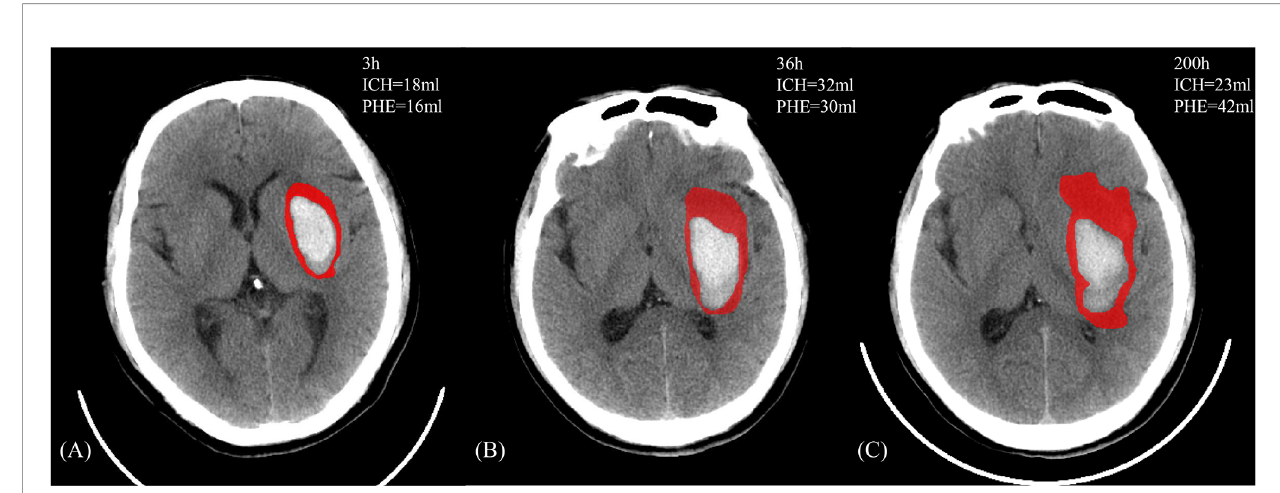
FIGURE 1 | A 47-year-old male who manifested weakness of the right limb and gradually developed mild disturbance of consciousness without clear inducement. There exists a past medical history with hypertension, which the admission blood pressure is 166/106 mmHg and the Glasgow Coma Scale score was 12. The head NCCT revealed left basal ganglia hemorrhage. The patient received the standardized medical management, and the discharge Glasgow Outcome Scale score is 3. (A – C) The image features of PHE (in red) and ICH against the onset